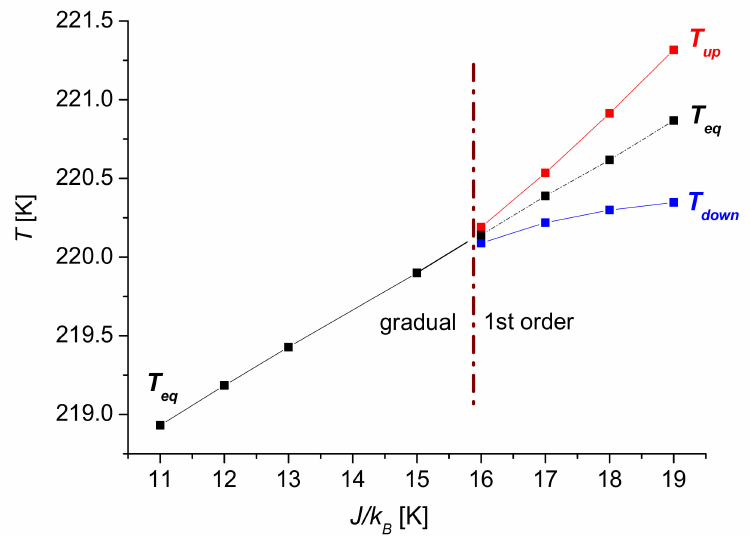
Figure 4. Temperature T versus J/k B for a 6 × 6 square lattice. The red ( T up ) and blue ( T down ) squares correspond, respectively, to the transition temperatures of the upper and lower branches of thermal hysteresis. The black squares correspond to the equilibrium temperatures ( T eq ) of the gradual transition region. The computational parameters are: ∆ / k B = 1300 K, G / k B = 172.2 K, x = ( J HH / k B ) / ( J LL / k B ) = 0.4 and ln( g ) = 6.01. Linear regression in the T eq ( J / k B ) variation gives: T ( J / k B ) = 0.24072 × J / k B +